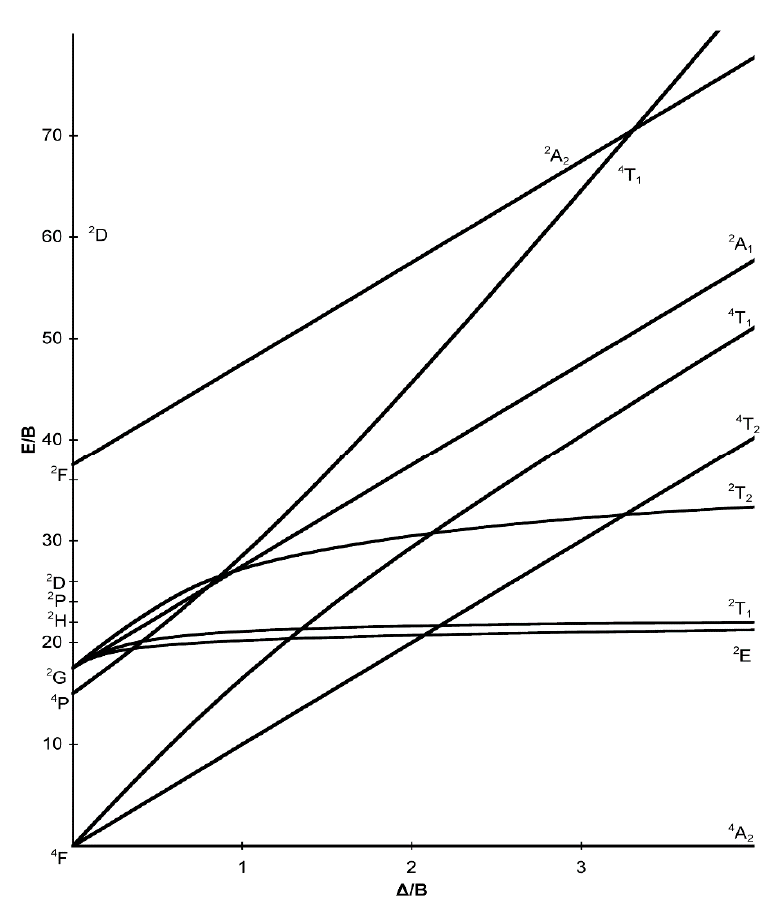
Figure 15. Tanabe–Sugano energy diagram for a d 3 transition metal complex with octahedral site symmetry. Various electronic states of the complex are listed as term symbols. For example, the term symbol 4 A 2 has a spin multiplicity of 4 and an orbital symmetry of A 2 . Tanabe–Sugano terms may also be written as 4 A 2g with the subscript g indicating an additional symmetry of the complex. The vertical axis is an energy axis; the horizontal axis is the ligand field strength or pressure axis [28,29]. The familiar 2 E g → 4 A 2g phosphorescence in ruby is a notable case in point.